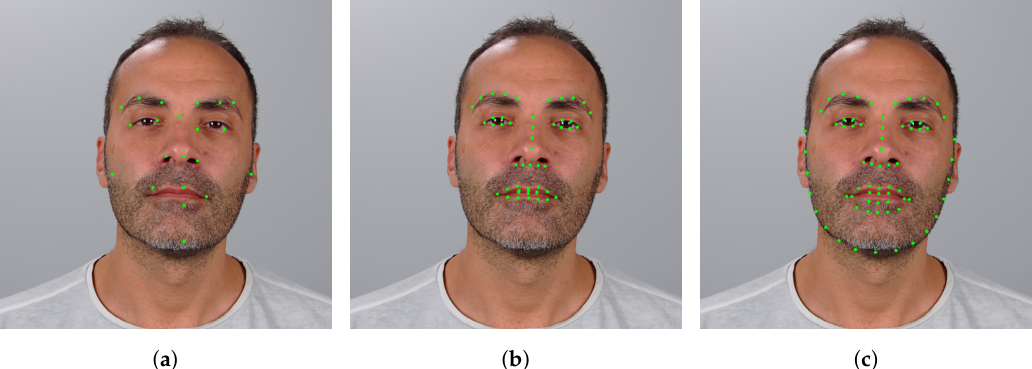
Figure 4. Face landmark detection: an example of output of three face landmark detectors. Face image extracted from the IST-EURECOM Light-Field Face Database (LFFD). ( a ) CLandmarks [40]; ( b ) IntraFace [41]; ( c ) DLIB.